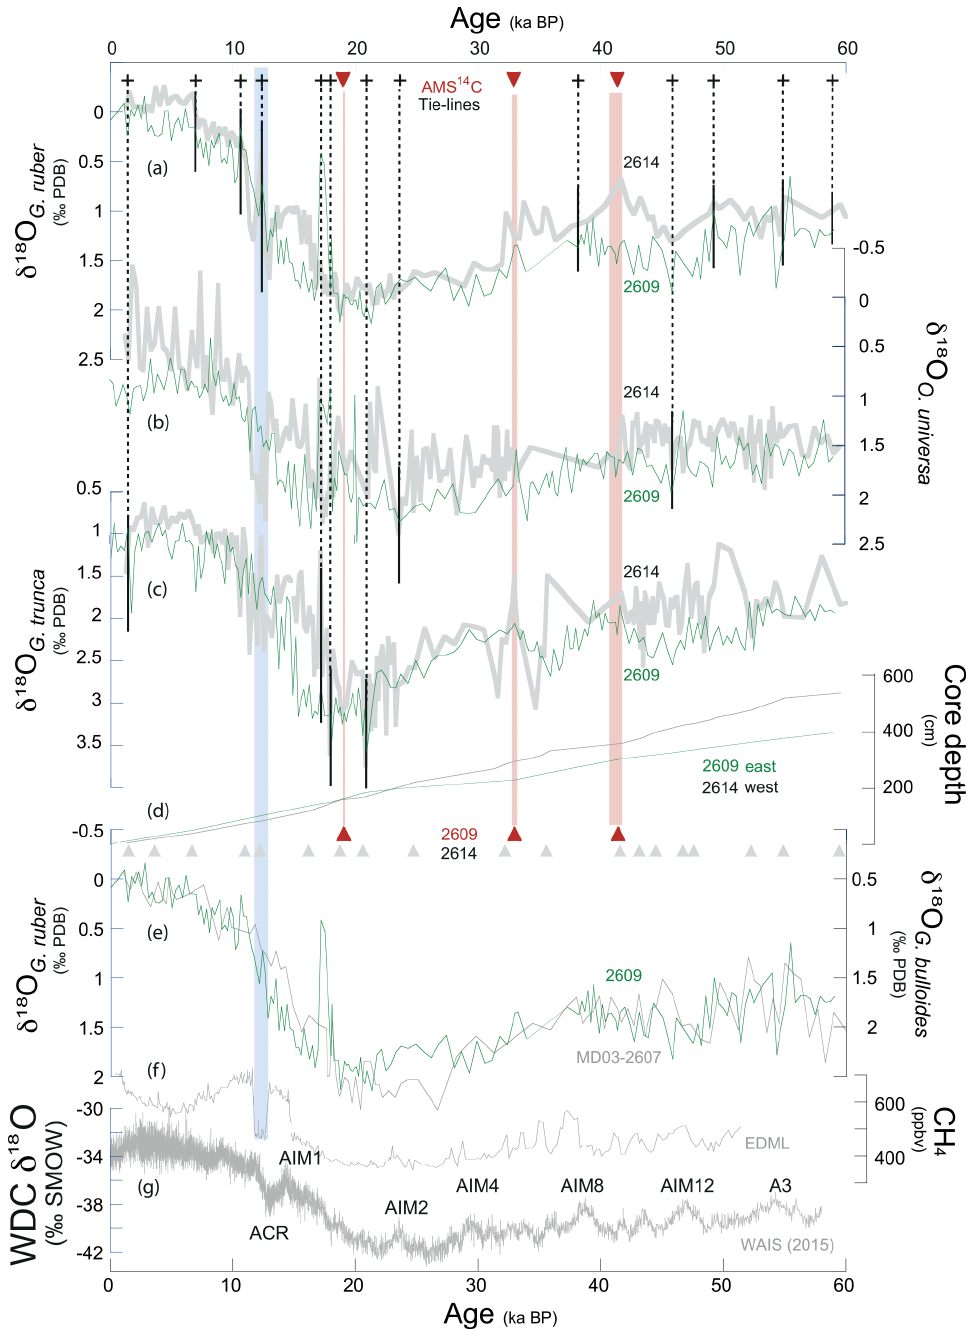
Figure 3. Chronostratigraphy of the eastern core 2609 (King Island). The age model is based on the tuning of various planktonic δ 18 O records of (a) G. ruber , (b) O. universa , and (c) G. truncatulinoides (all in green lines) to similar records (thick grey lines) of the well-dated reference core 2614 (van der Kaars et al., 2017). In total, 13 tuning tie lines (stippled lines; solid for the species-specific correlations) were set in order to achieve an optimal fit of the core 2609 and core 2614 δ 18 O records (mean r 2 = 0 . 86). The age model for core 2609 is supported by three AMS 14 C datings (red triangles and red lines; red shading marks the 1-sigma errors). (d) Sedimentation rates (green = core 2609; grey = core 2614). Grey triangles are age control points established for core 2614 by van der Kaars et al. (2017). (e) The age model for core 2609 is supported by the match of its δ 18 O G. ruber record (green) to the adjacent core MD03-2607 δ 18 O G. bulloides record (grey; Lopes dos Santos et al., 2013). (f) Atmospheric CH 4 record from EPICA ice core (EPICA Community Members, 2006). Blue shading denotes prominent atmospheric CH 4 anomaly synchronous to a distinct reflection in the core 2614 δ 18 O O. universa record. (g) West Antarctic Ice Sheet Divide Core δ 18 O record (WAIS Divide Project Members, 2015) as reference for the Southern Hemisphere climate signal.